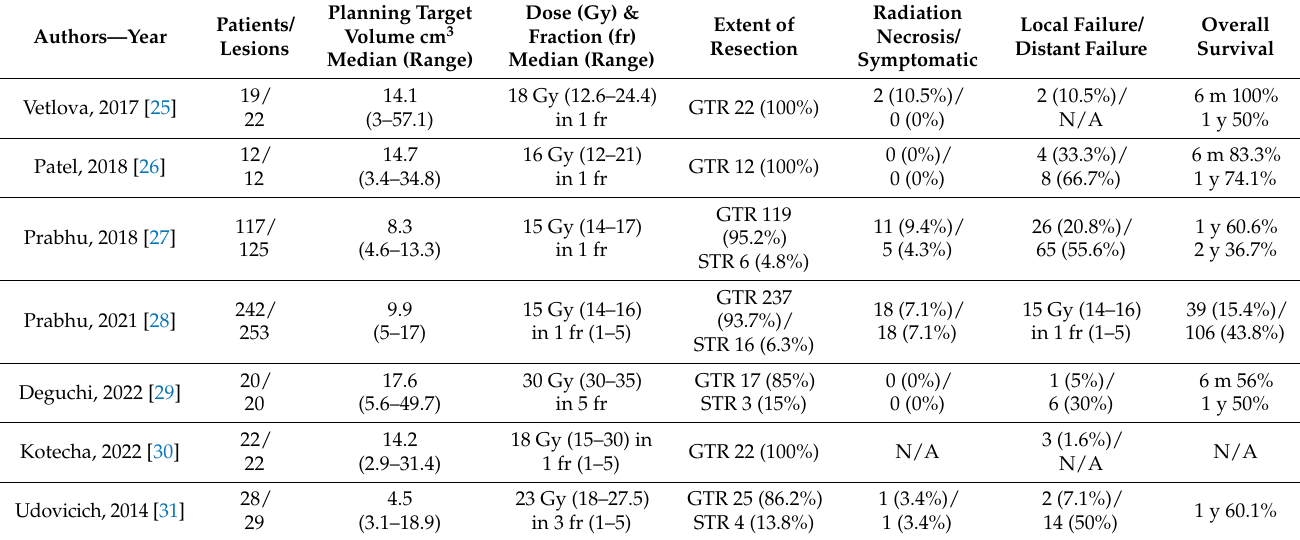
Table 1. Overview of all included studies.